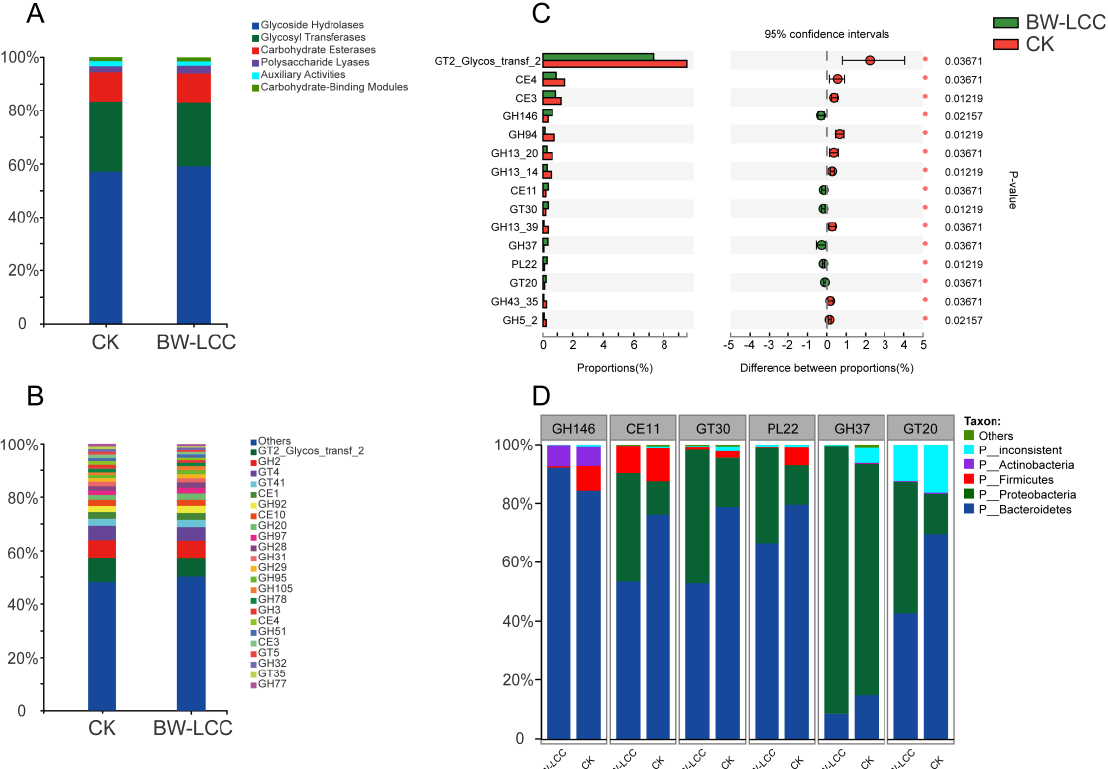
Figure 5. Comparison of CAZymes between the BW-LCC and CK groups at the class (A) and genus (B) levels. Wilcoxon rank-sum tests indicate significant differences at the family level (*, P < 0.05) ( C ). Species contribution of CAZyme families that were significantly enhanced ( D ).